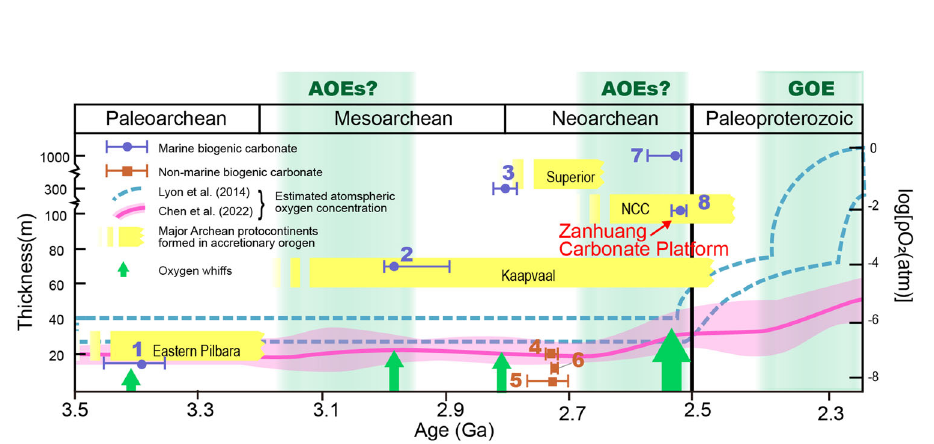
Fig. 10 | Schematic diagram illustrating connection between protocontinent emergence in the Archaean and biogenic carbonate distribution. Violet/bronze solid point with error bar for: depositional age of marine/non-marine biogenic carbonate. Blue curve : emerging model of oxygen level ( ρ O 2 (atm), atmospheric partial pressure of O 2 ) 68 . Pink Curve : atmospheric O 2 variation using machine learning 67 . Green arrows : possible ‘ whiffs ’ of O 2 coupling carbonate platform emergence. Vertical green bars : suggested oxidation evens, from 67 . GOE: Global oxidationevent.AOE:Archaeanoxidationevent.(1)StrelleyPoolFormation,Pilbara